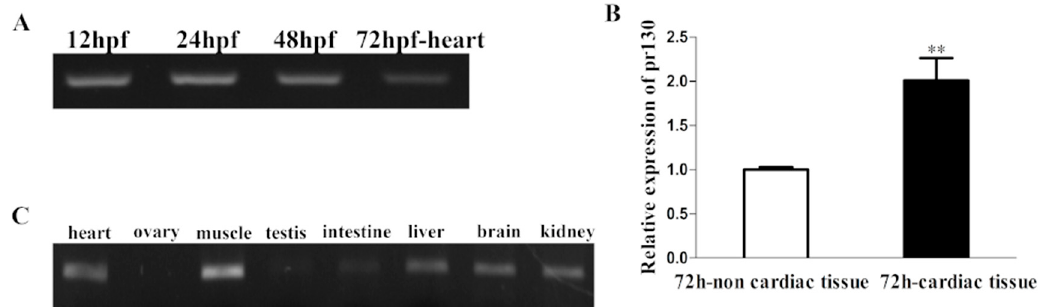
Figure 1. Expression patterns of pr130 in zebrafish. ( A ) Expression of pr130 at different stages in whole fish during zebrafish embryogenesis and in 72 hpf-heart; ( B ) Relative expression of pr130 in non-cardiac tissue and cardiac tissue of 72 hpf embryos was identified using real-time reverse transcription-polymerase chain reaction (RT-PCR); ( C ) The expression of pr130 in different tissues of adult zebrafish. Data represent the mean ± SD. **, p < 0.01.